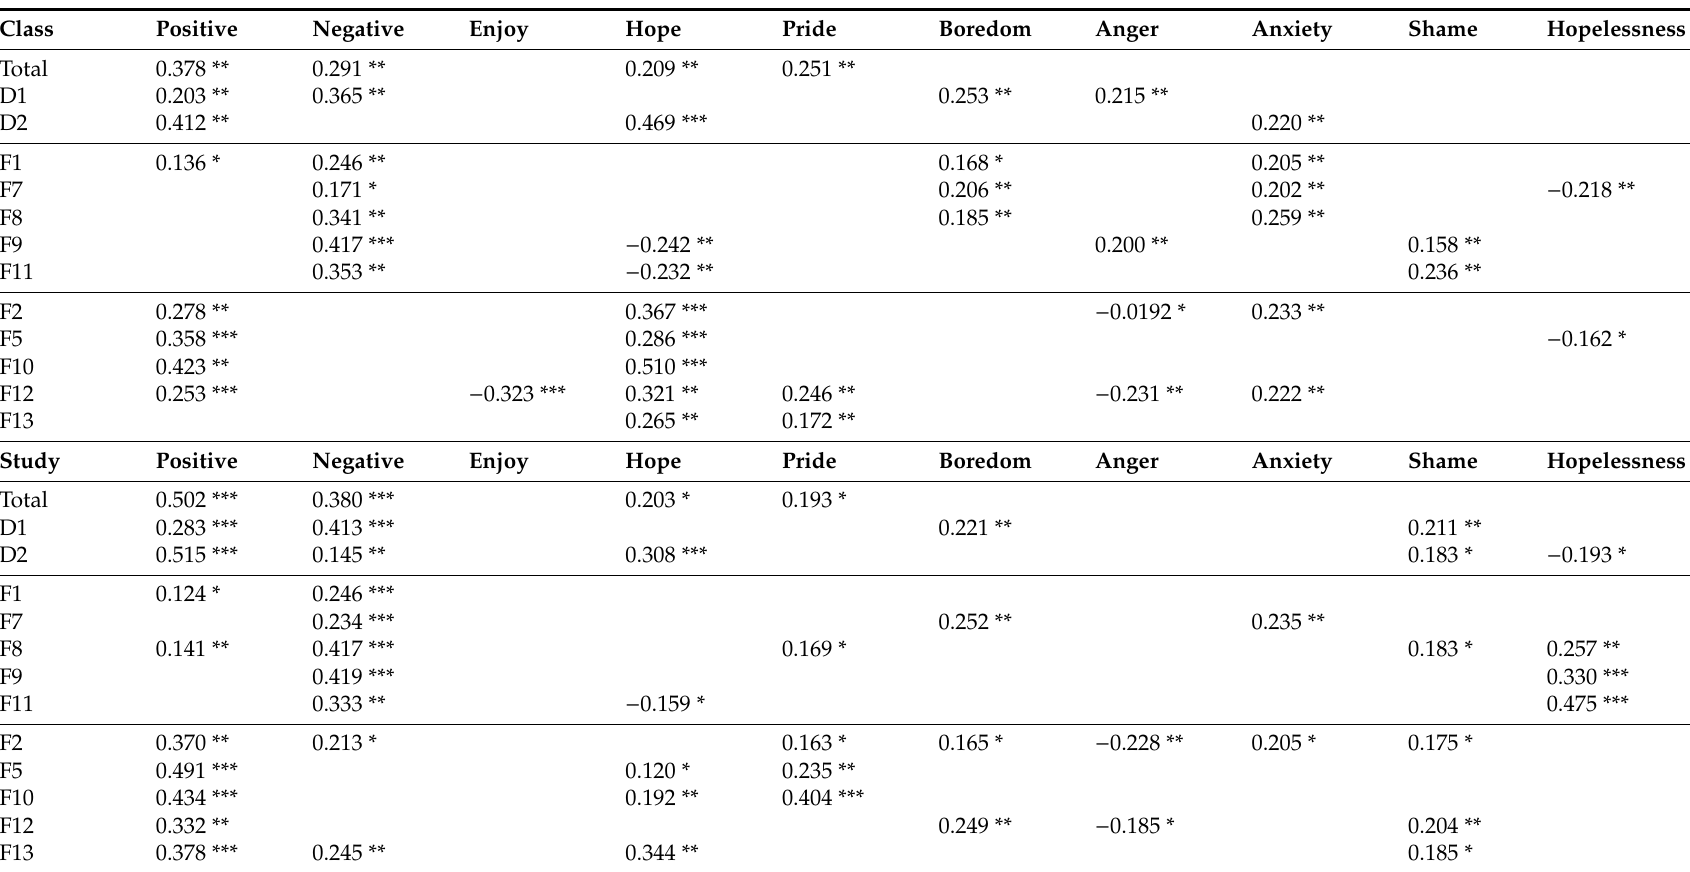
Table 2. Linear regression coe ffi cients (Beta) between Achievement Emotions (IV) and Coping Strategies (DV) with levels of stress (Class = level 1; Study = level 2; Test = level